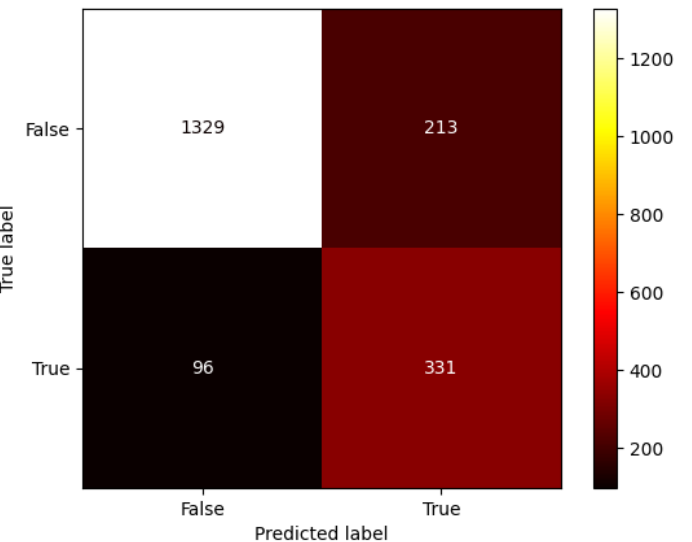
Figure 6. Pictorial representation of the confusion matrix subjected to Ethereum Fraudulence Prediction with detailed annotations. The Chaos Feature Extractor suspected 331 transactions complemented with k-nearest neighbors to be fraudulent which were in fact fraudulent. The algorithm declared 1329 transactions to be genuine which were in fact genuine.